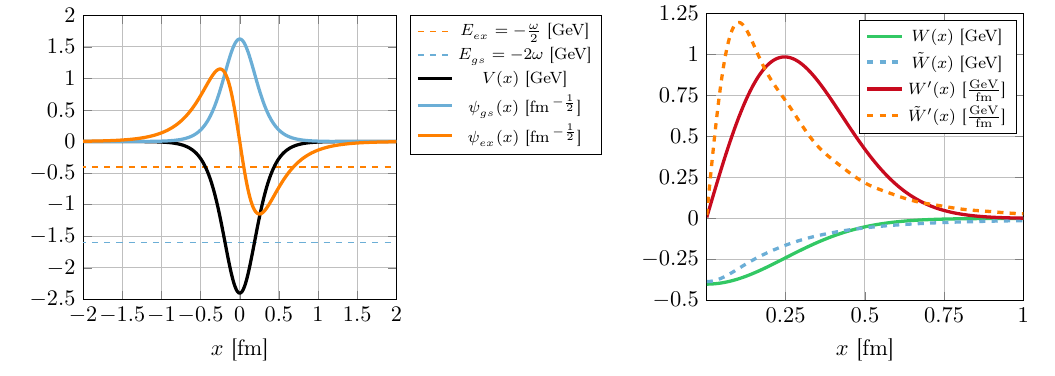
Figure 2 . On the left: P(cid:127)oschl-Teller potential with ! = 0 : 8 GeV, (cid:22) = 0 : 6 GeV and j = 2 bound states. The ground state and (cid:12)rst excited state with their energies are also shown. On the gs ex right: imaginary part of the potential (6.5) used in the simulations contrasted with ~ W ( x ) derived from the gauge theory in (3.8). Here T = 0 : 8 GeV and (cid:27) = 1 , hence l env = ~ = ( (cid:27)T ) 0 : 25 (cid:25)